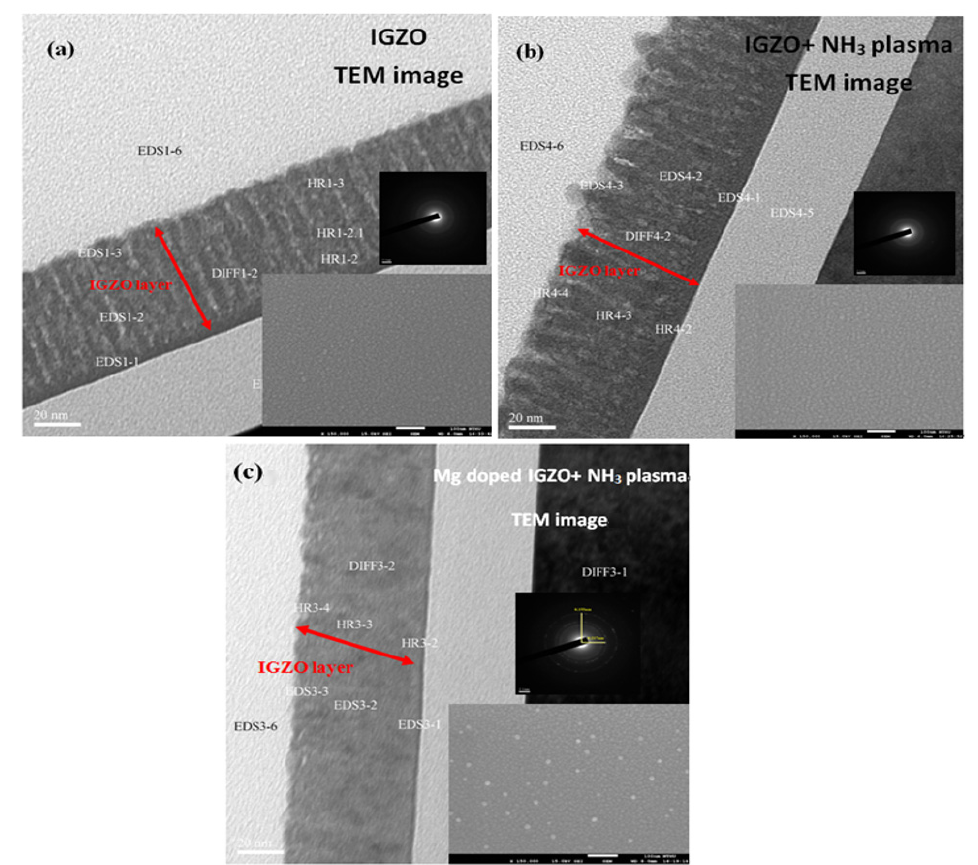
Figure 2. TEM images with SAED, FESEM sub-images for ( a ) IGZO sample ( b ) IGZO with NH 3 plasma treatment ( c ) Mg doped IGZO with NH 3 plasma treatment.